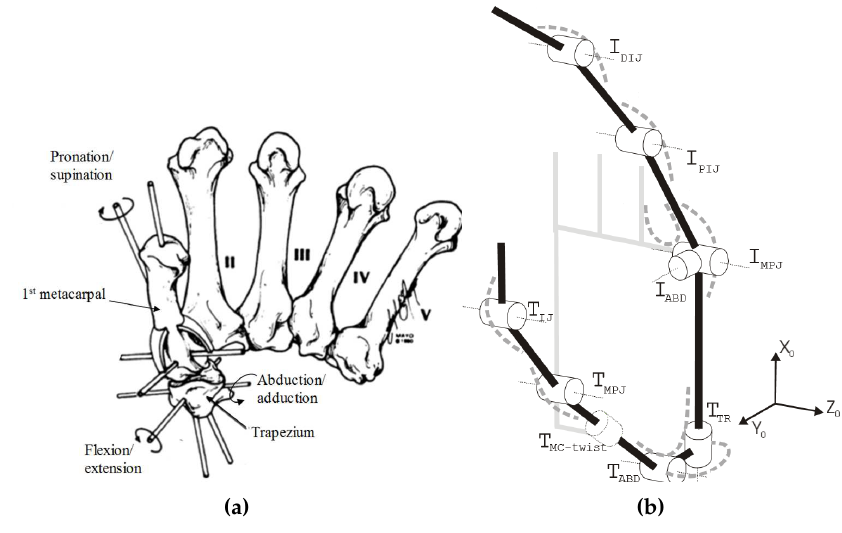
Figure 8. Examples of finger joint models; ( a ) Anatomical model for the CMC joint [18]; ( b ) finger joint model for the cyberglove